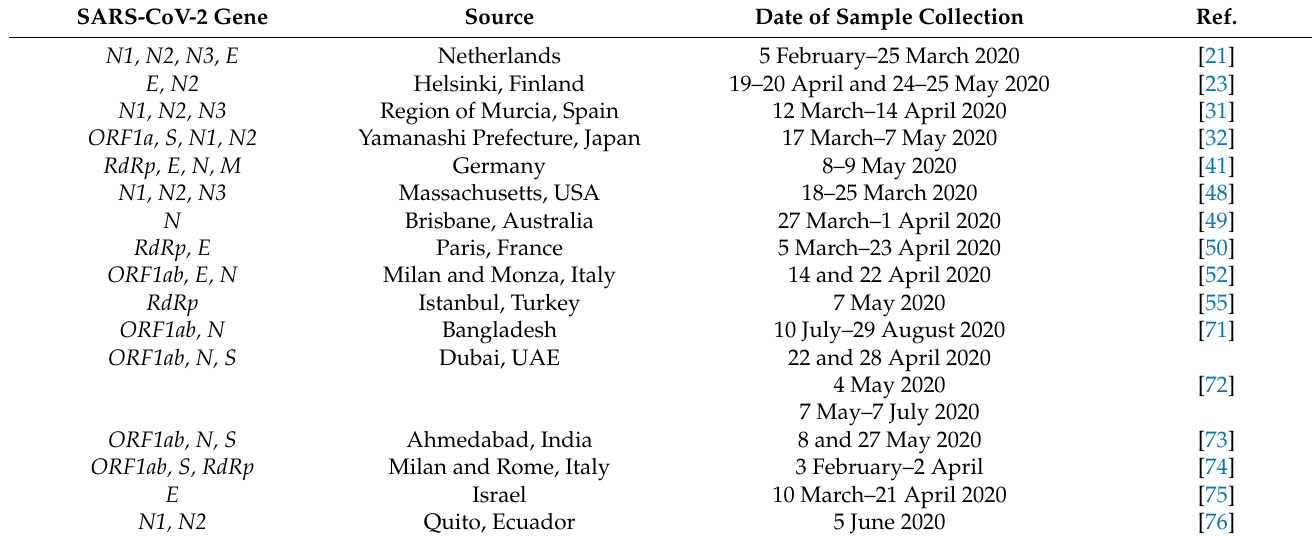
Table 1. Overview of some important wastewater-based epidemiology studies for SARS-CoV-2. SARS-CoV-2 Gene Source Date of Sample Collection